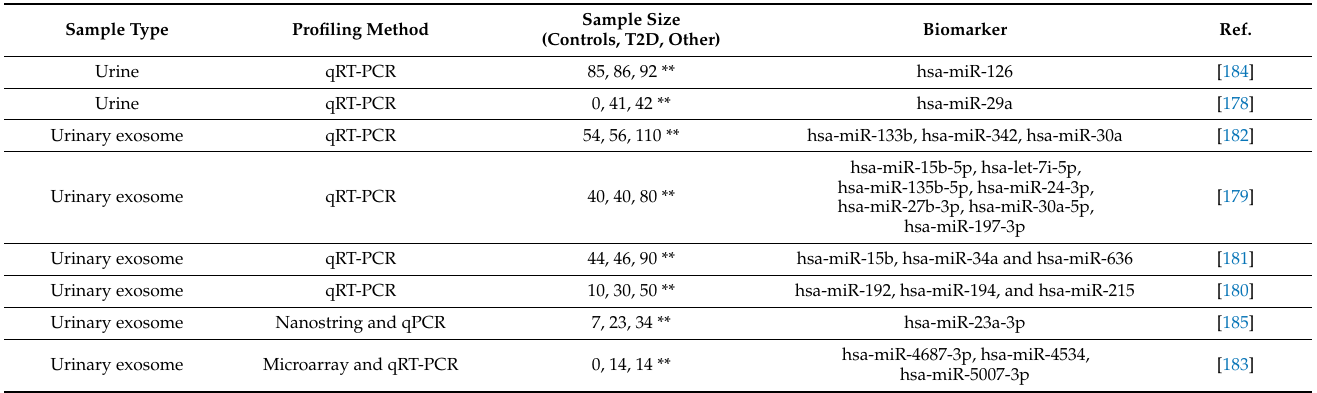
Table 10. microRNA biomarkers from urine samples for